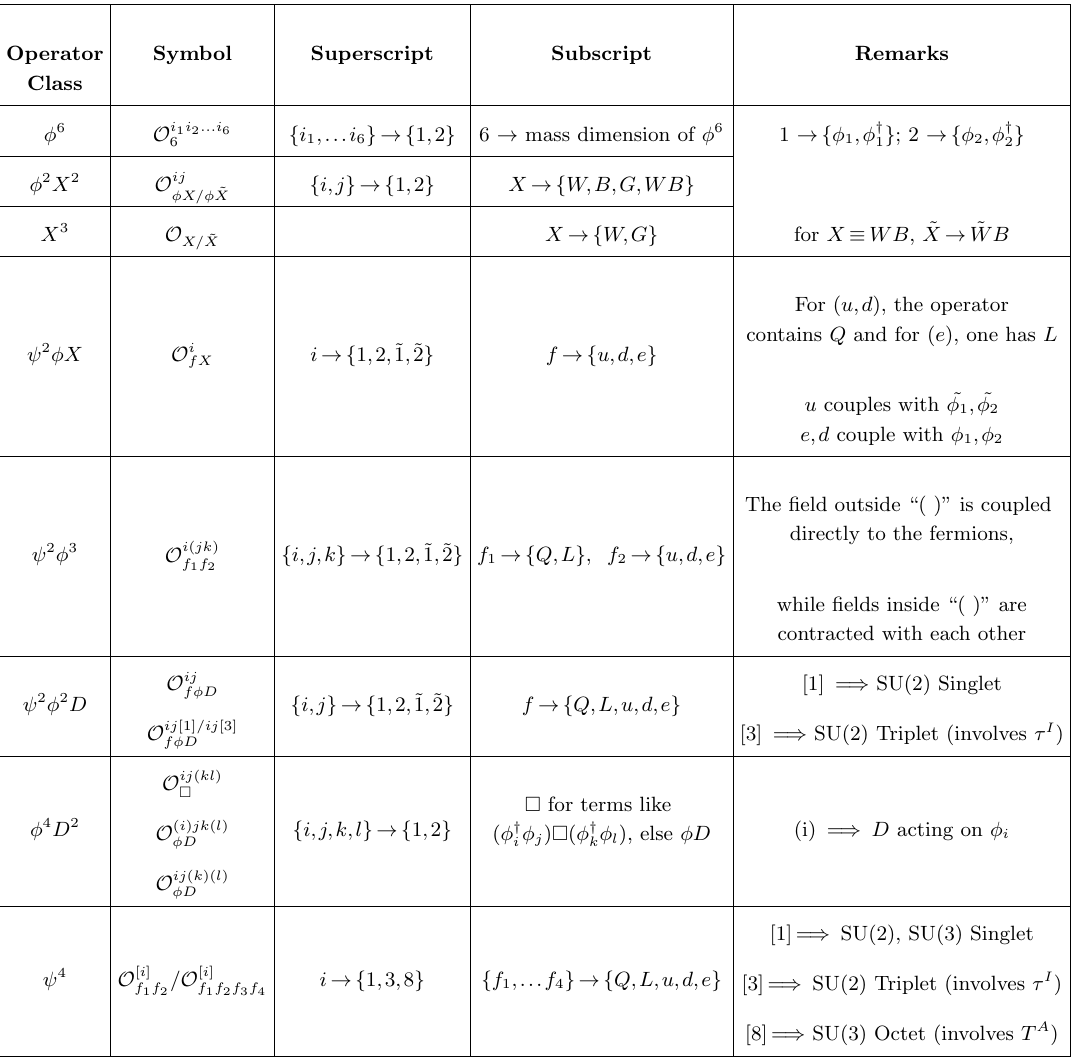
2 = 6] class of operators. (cid:2)